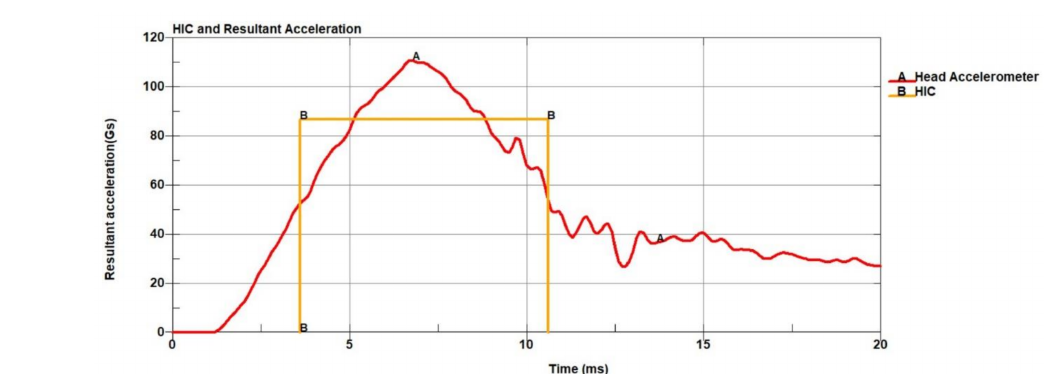
Brain Sci. 2021 , 11 , x FOR PEER REVIEW Figure A5. HIC and resultant acceleration (g) in time (ms) plot (HIC = 499).